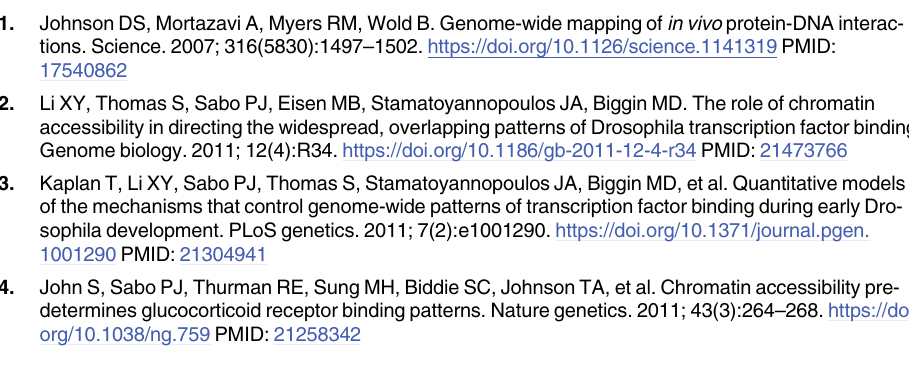
S6 Fig. The impact of chromatin accessibility on the sensitivity of ChIP-seq. Left panel: The mean chromatin accessibility, as defined in the main text, is varied along the x-axis with the area under the ROC (auROC) on the y-axis. Equal numbers (1000) of true and false positive binding sites is set to be equal to 1000 each. The binding energy distribution of the true posi- tive sites is set to be a power law truncated between 0 and 6 k T with an exponent of 0.5, and B the false positive site binding energies are distributed as a truncated power law between 0 and 6.78 k T with an exponent of 0.76. This corresponds to a mean occupancy ratio of 2 between B the true and false positive binding sites. Chromatin accessibility is varied by changing β in Eq 8 in the main text. Right panel: A Gaussian kernel density estimate of the chromatin accessibility distribution corresponding to β = 0.5 (black), β = 5.0 (blue), β = 10.0 (orange). The mean cor- responding to each value is shown in the plot legend. (TIF) S1 Table. The structural class of the motifs of TFs analyzed in S3 and S4 Figs. Information on the structural class of the TFs was taken from the TransFac database. The binding energy matrices were taken from the BEEML database.